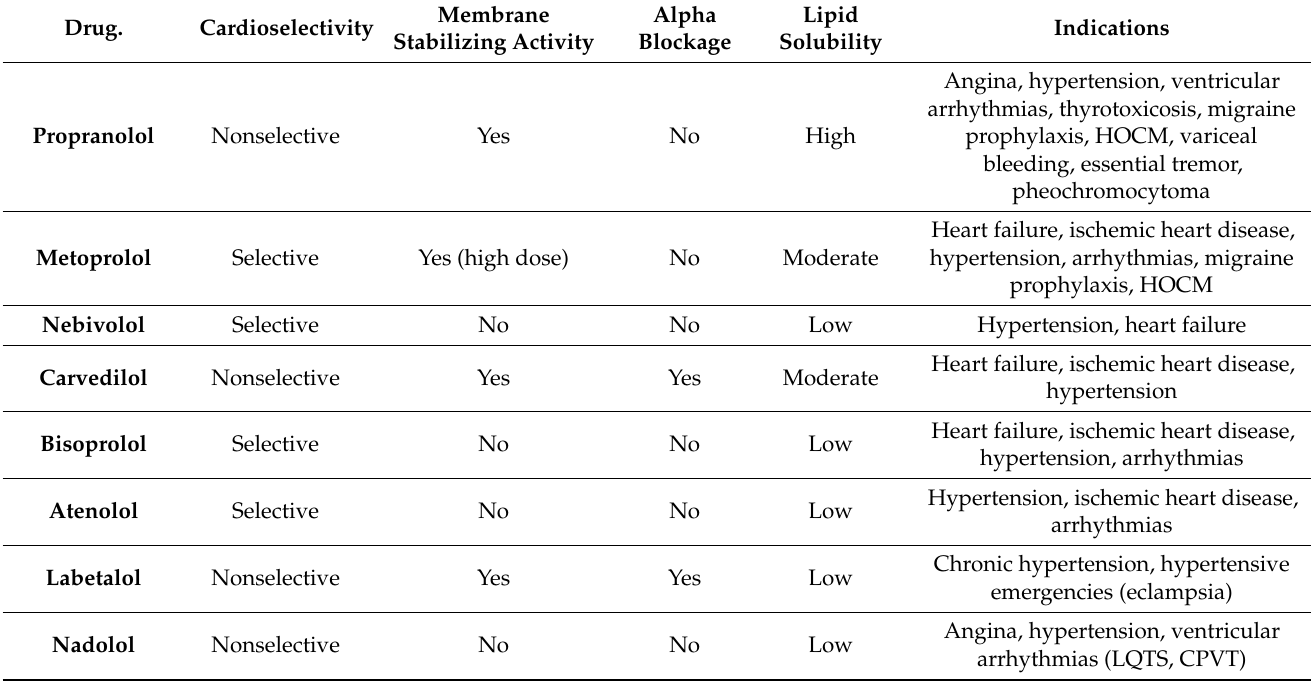
Table 2. Properties and clinical use of principal β